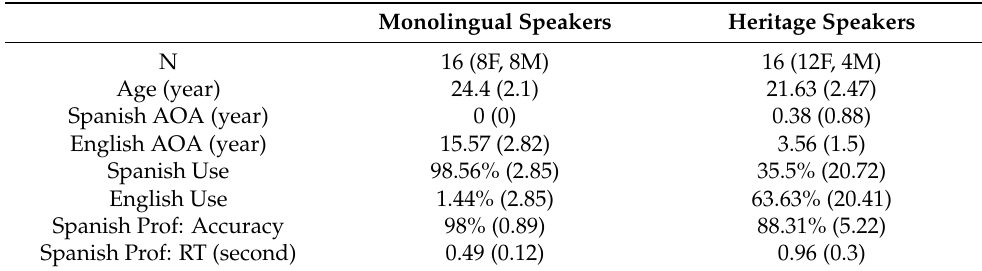
Table 1. Participant’s language